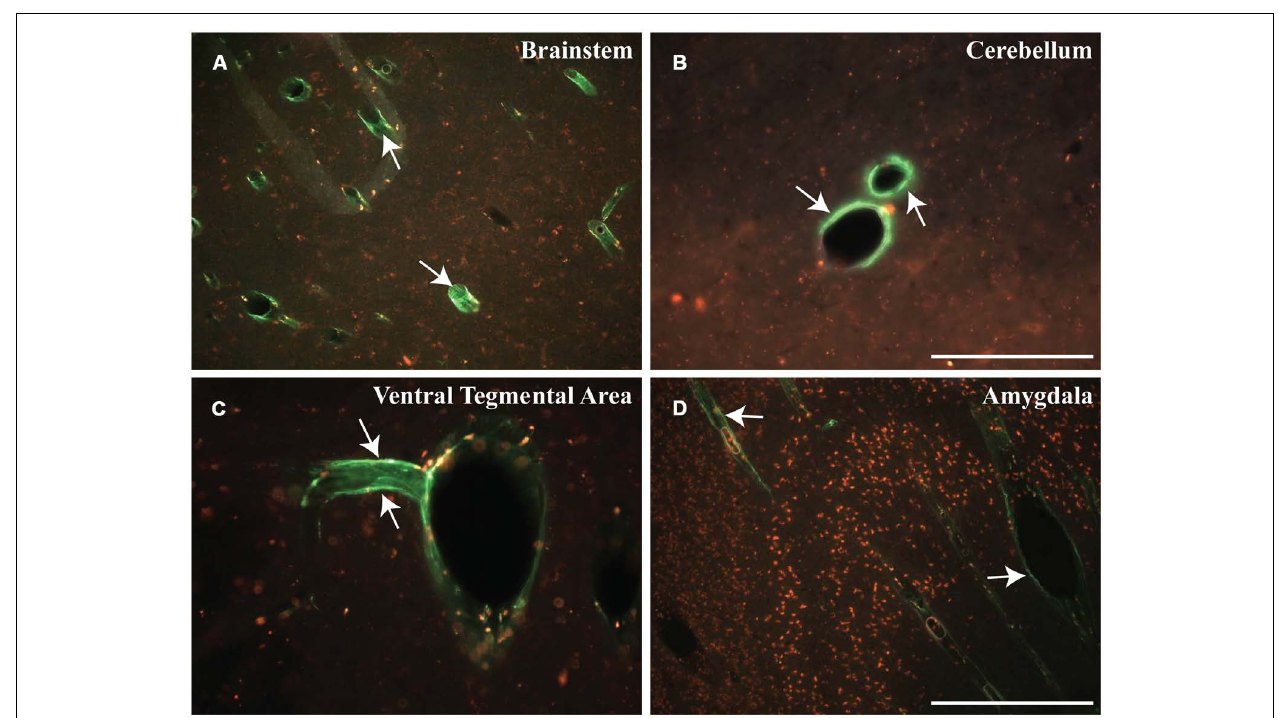
FIGURE 6 | Early distribution of micelles. (A–D) Cisternal injection of fluorescently labeled micelles (shown in green) indicate the rapid transport of these particles within different regions of the NHP brain.These micelles filled the perivascular space of blood vessels throughout the brain, particularly in